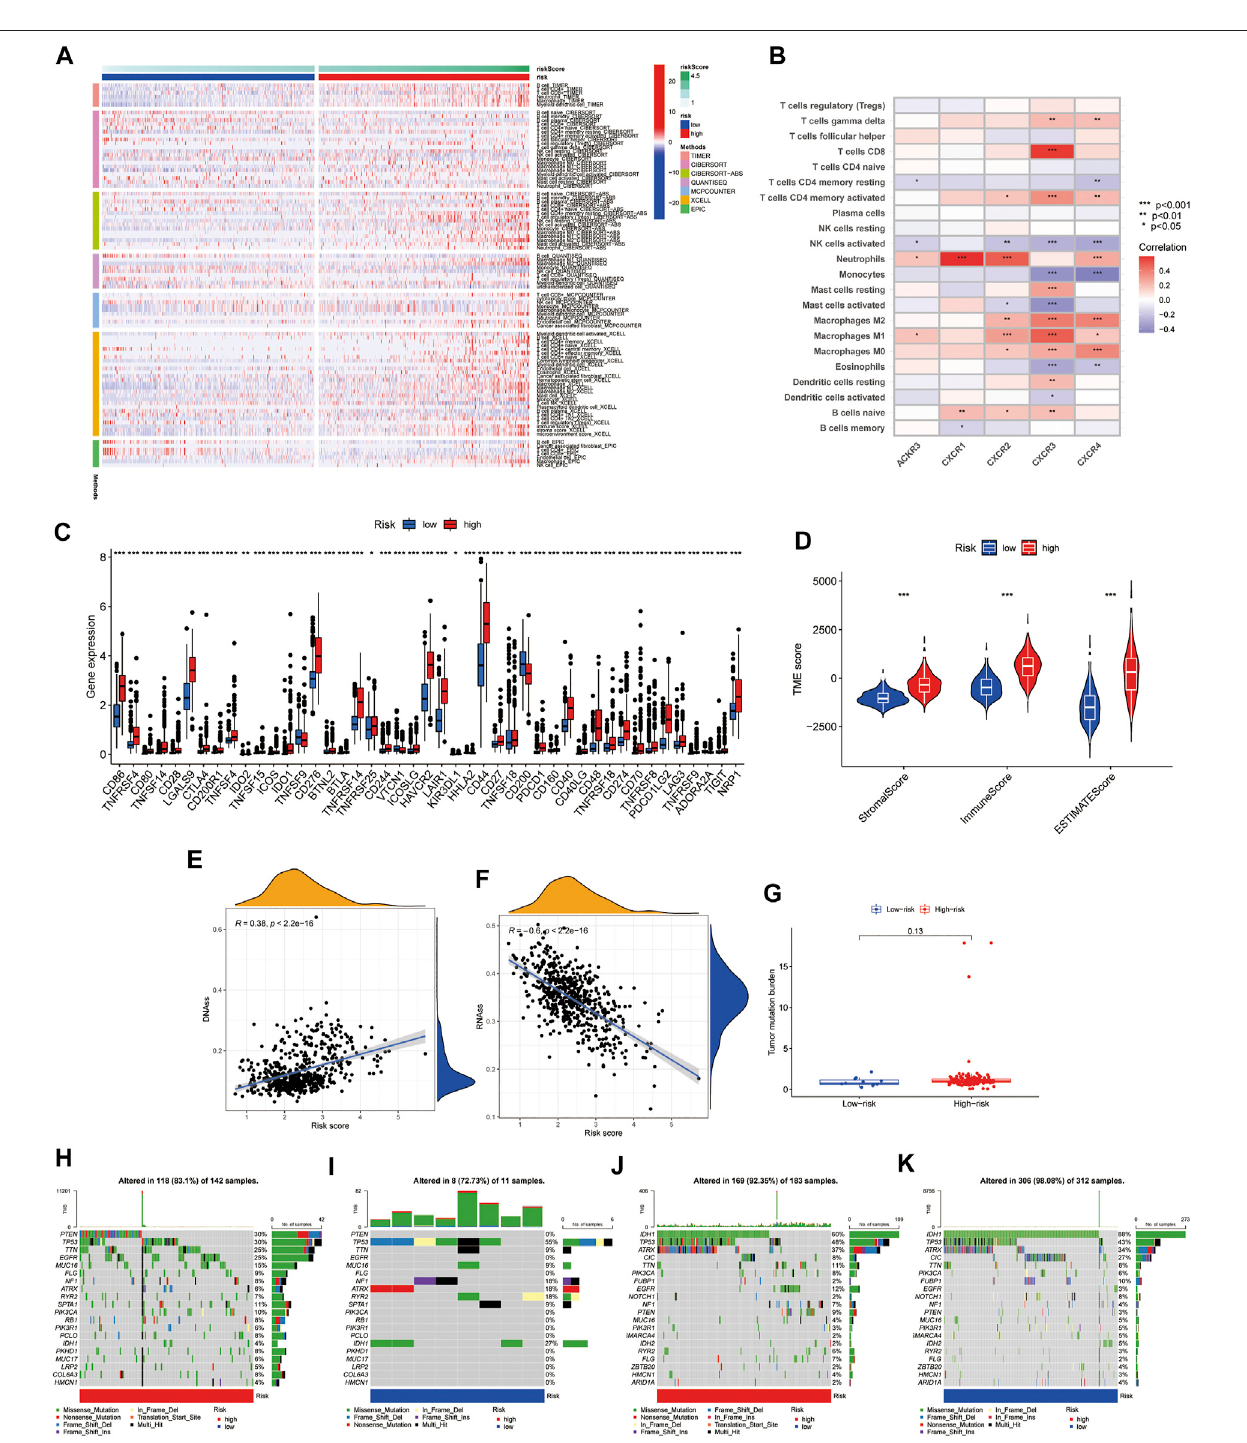
FIGURE7| CorrelationofCR-ScoreandwithTME,CSCindex,immunecheckpoints,andmutation. (A) ThethermogramindicatesthefrequencyofTMEin fi ltrating cells among high- and low-risk group. (B) Relationshipsbetween thein fi ltrating levels of22immunecell types and thedifferentially expressed genes. (C) The expression of immune checkpoint genes. (D) Associations between the CR-Score and TME score. Relationships between CR-Score and CSC index. (E) DNAss. (F) RNAss. (G) Correlations between CR-Score and TMB. (H – K) Waterfall plot of somatic mutation pro fi les established with high and low CR-Scores in each sample. Data are shown as the mean ± SD; t test, * p < 0.05, ** p < 0.01 and *** p < 0.001 compared to the high-risk group in (B – D) .